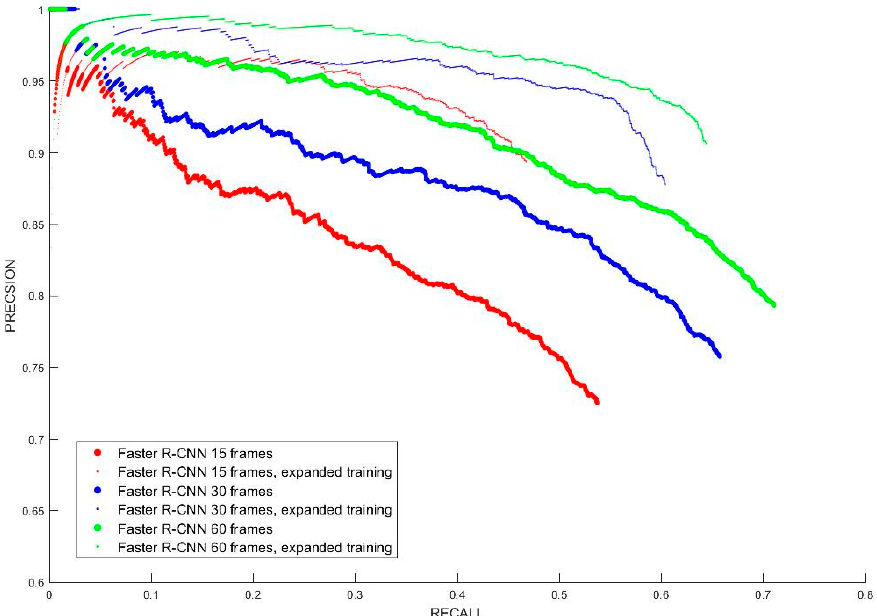
Figure 7. The average precision curve for the Faster R-CNN model which was trained on a training dataset and additionally tuned in three considered cases with 15, 30, and 60 frames.